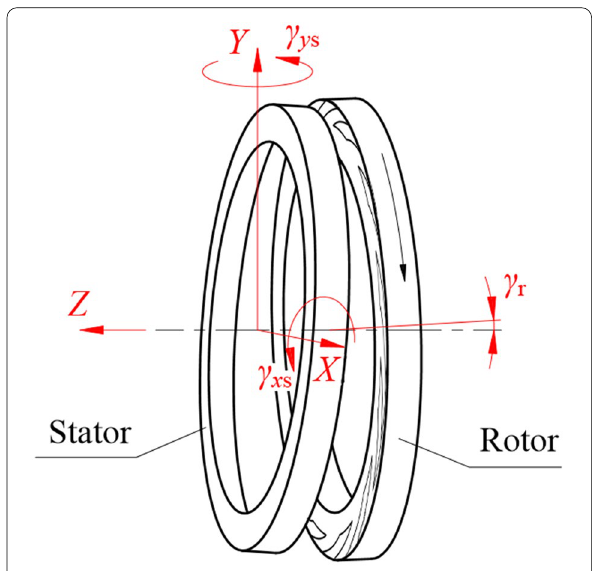
Figure 3 Movements of the seal